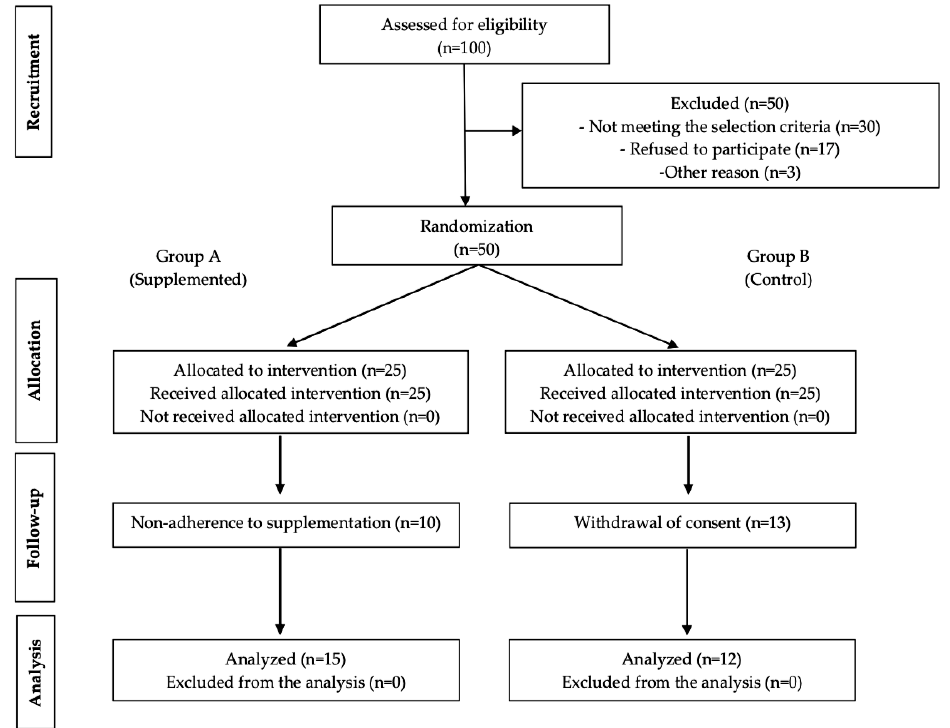
Figure 1. Flow diagram of patient progress through the phases of the randomized trial.